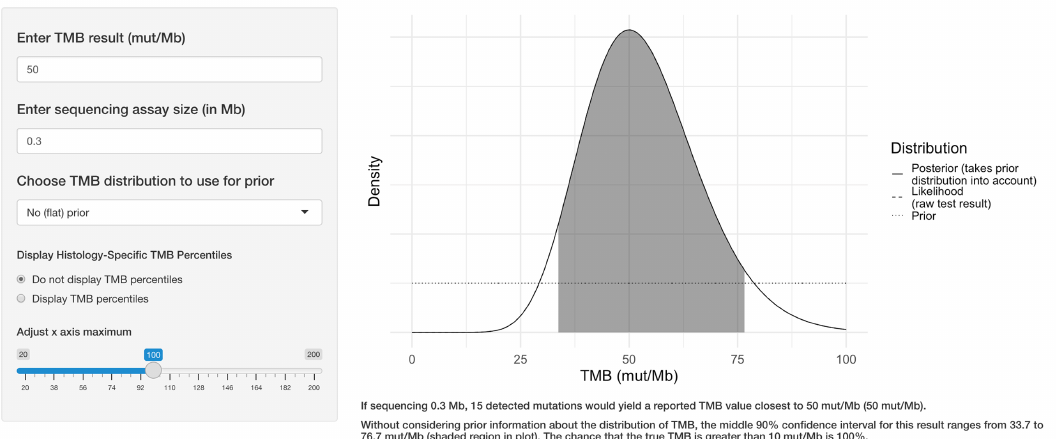
Figure 6. If many mutations are identified far from the 10 mut/Mb threshold, even very small panels can reliably establish that a tumor is TMB-high with